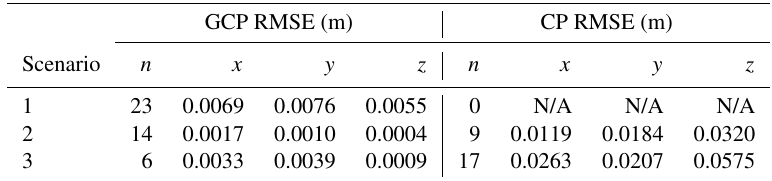
Table 2. Summary results of alternative ground control point (GCP) and check point (CP) scenarios tested for aero-triangulation within UAS